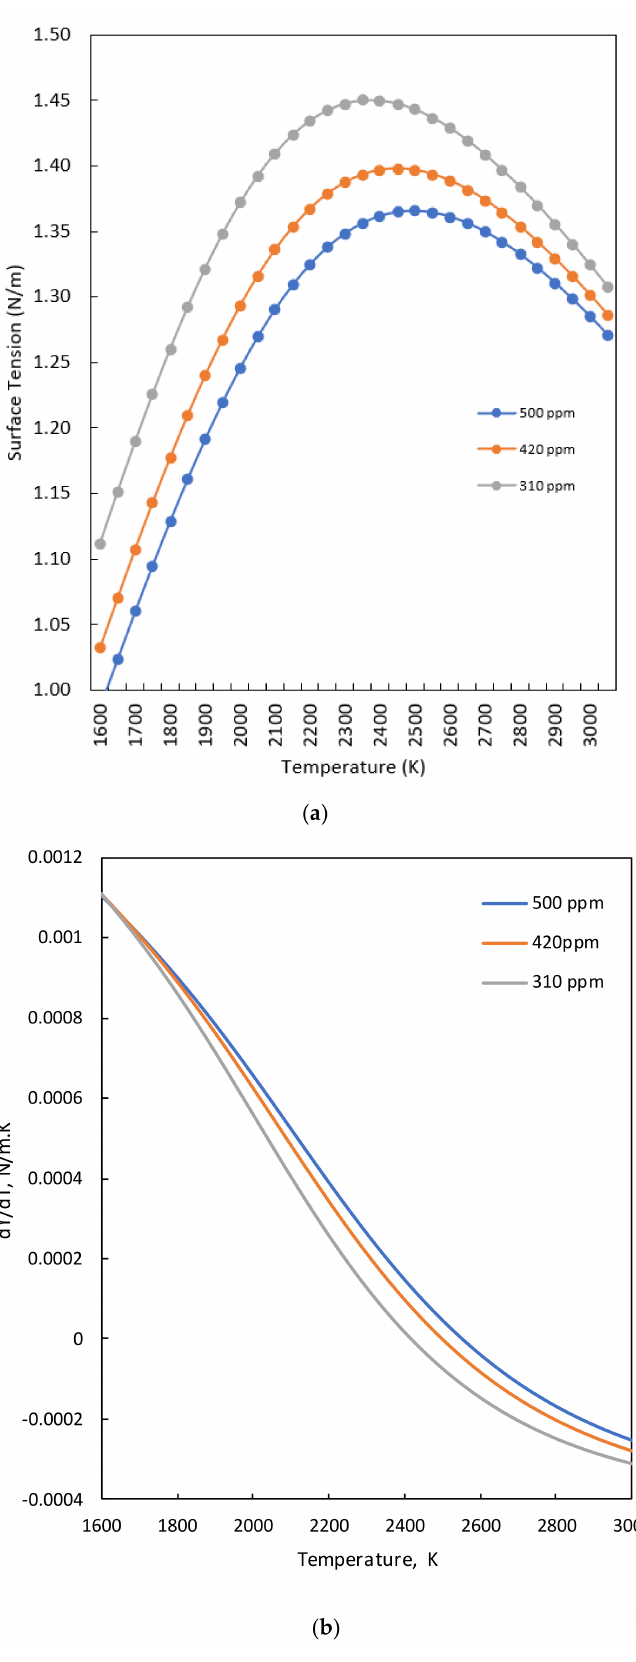
Figure 10. Surface tension relationship with respect to oxygen concentration ( a ) surface tension and ( b ) surface tension